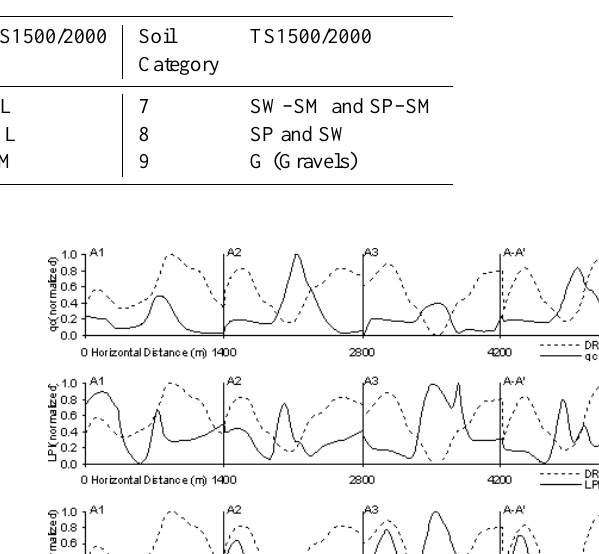
Table 3. Soil categories used in the soil map.